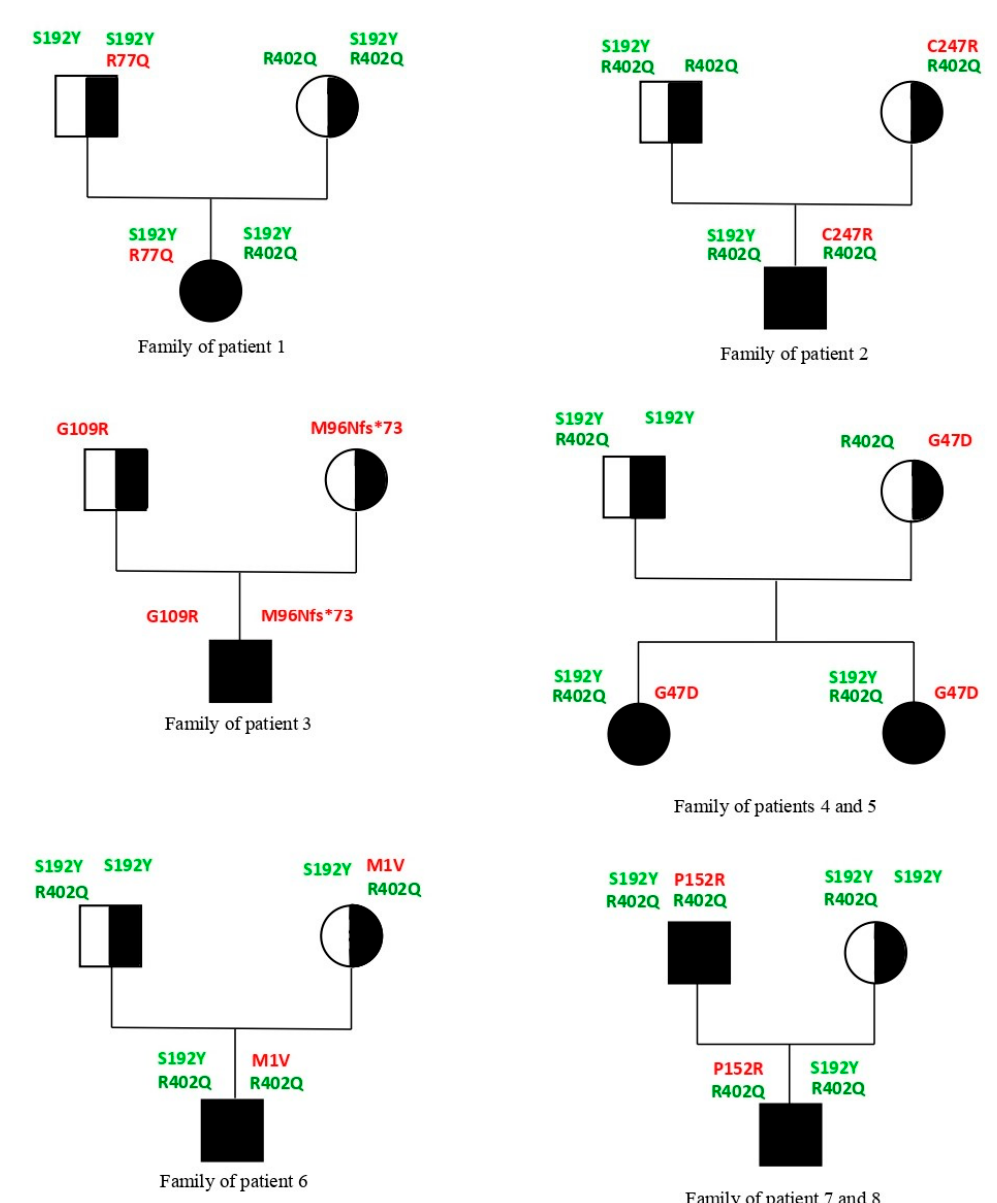
Figure A2. Family pedigrees (in red TYR pathogenic variants, in light green the p.(Ser192Tyr) polymorphism and in dark green the p.(Arg402Gln)polymorphism) Table A1. Detailed variant information.